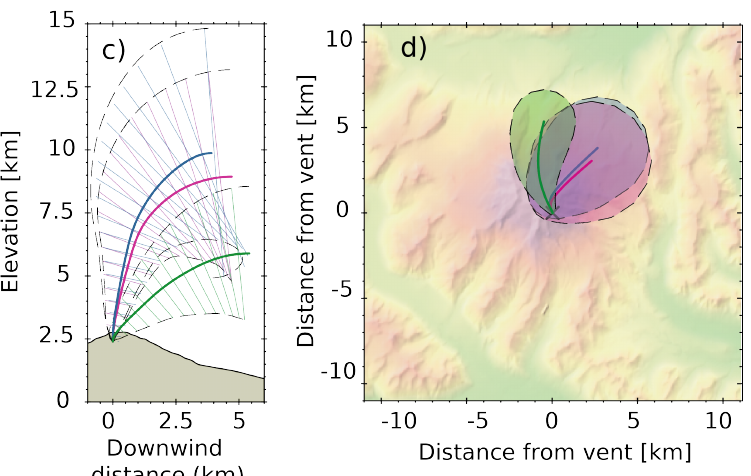
Figure 4. Infrasound-derived gas flow velocities, and plume models for an explosion at Mt. Redoubt, USA, on 23 March 2009: ( a ) raw infrasound signal recorded at 12 km from the vent; ( b ) five-second moving window gas velocity time series calculated for monopole, dipole, and quadrupole infrasound sources by inverting Equations (1)–(3); and ( c , d ) cross-section (in the downwind direction) and map view of modelled plumes using measurements of local atmospheric conditions at the time of eruption. Initial flow velocities in the plume models corresponds to peak gas velocities from infrasound for monopole, dipole and quadrupole sources (colour coding consistent across ( b – d )). The figure reproduces and expands results originally presented in Lamb et al.